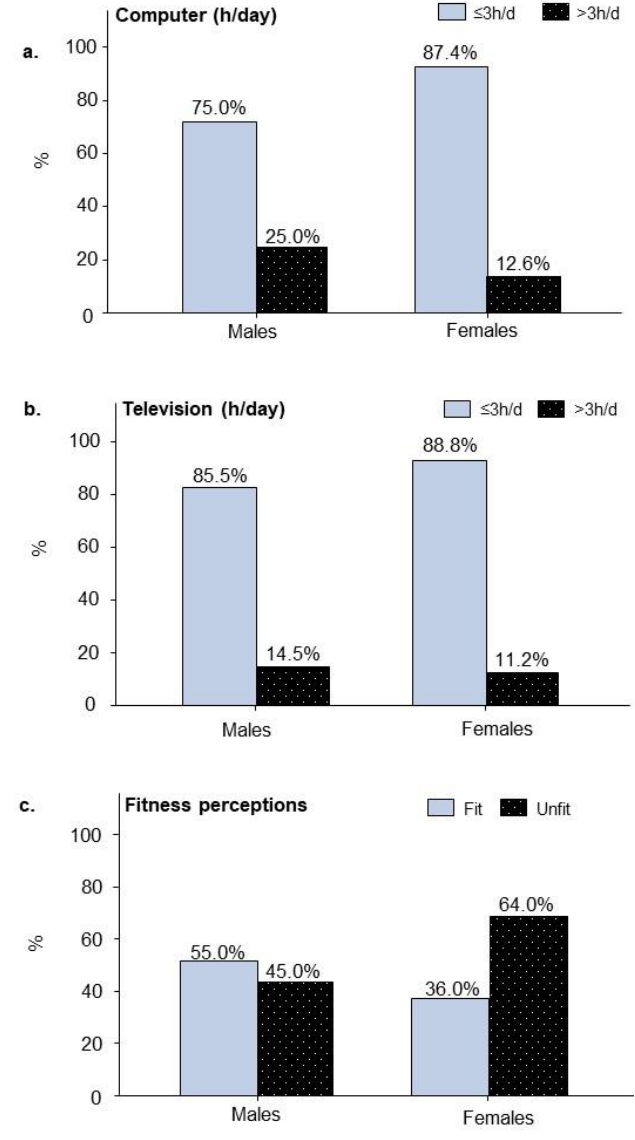
Figure 3. Differences in leisure-time sedentary screen behaviours and fitness perceptions between male ( n = 200) and female adolescent students ( n = 214). ( a ) Percentages of students engaged in leisure-time computer activity (h/day). ( b ) Percentages of students engaged in leisure-time television (TV) activity (h/day). ( c ) Percentages of students separated by self-assessed fitness perception. The influence of physical activity levels are given by the p -values and odds ratios (OR) that follow: sedentary behaviours including ( a ) computer (h/day), p -value 0.0067, OR 1.887 (1.192, 2.985) and ( b ) watching television, p -value 0.0052, OR 0.402 (0.213, 0.762); ( c ) fitness perceptions, p -value <.0001, OR 0.325 (0.208, 0.507).